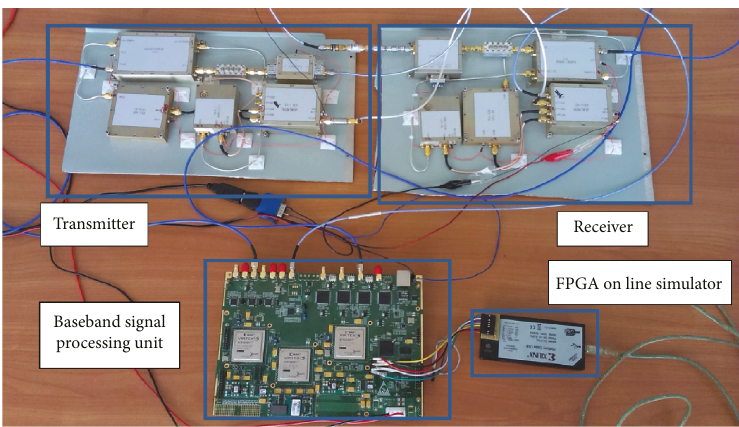
Figure 11: Relative measurement sensor ranging precision veri fi cation experiment.